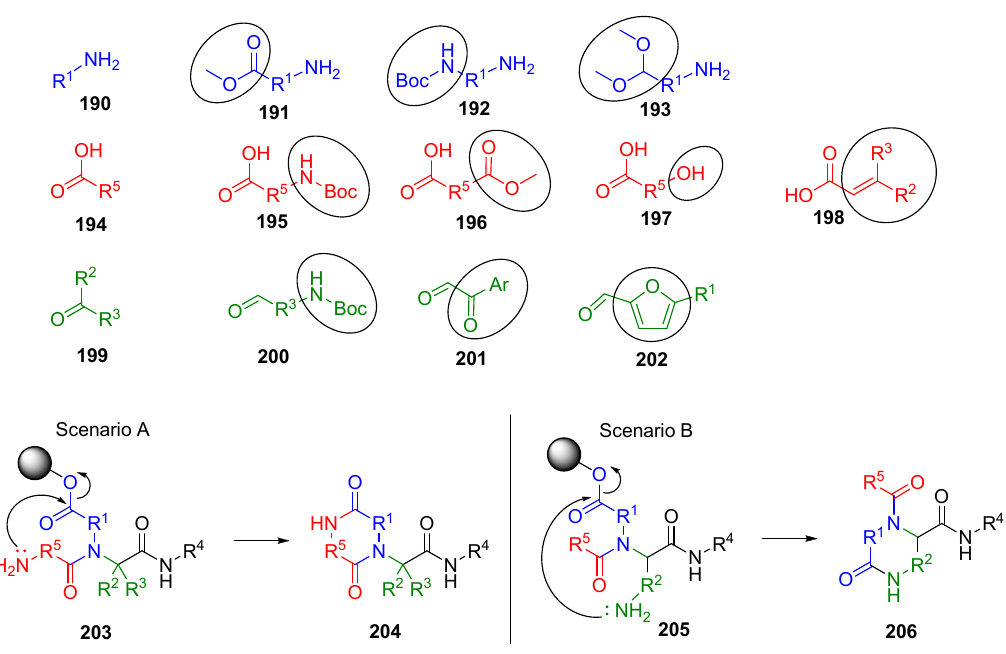
Figure 3. Examples of bifunctional BBs and ring closures.